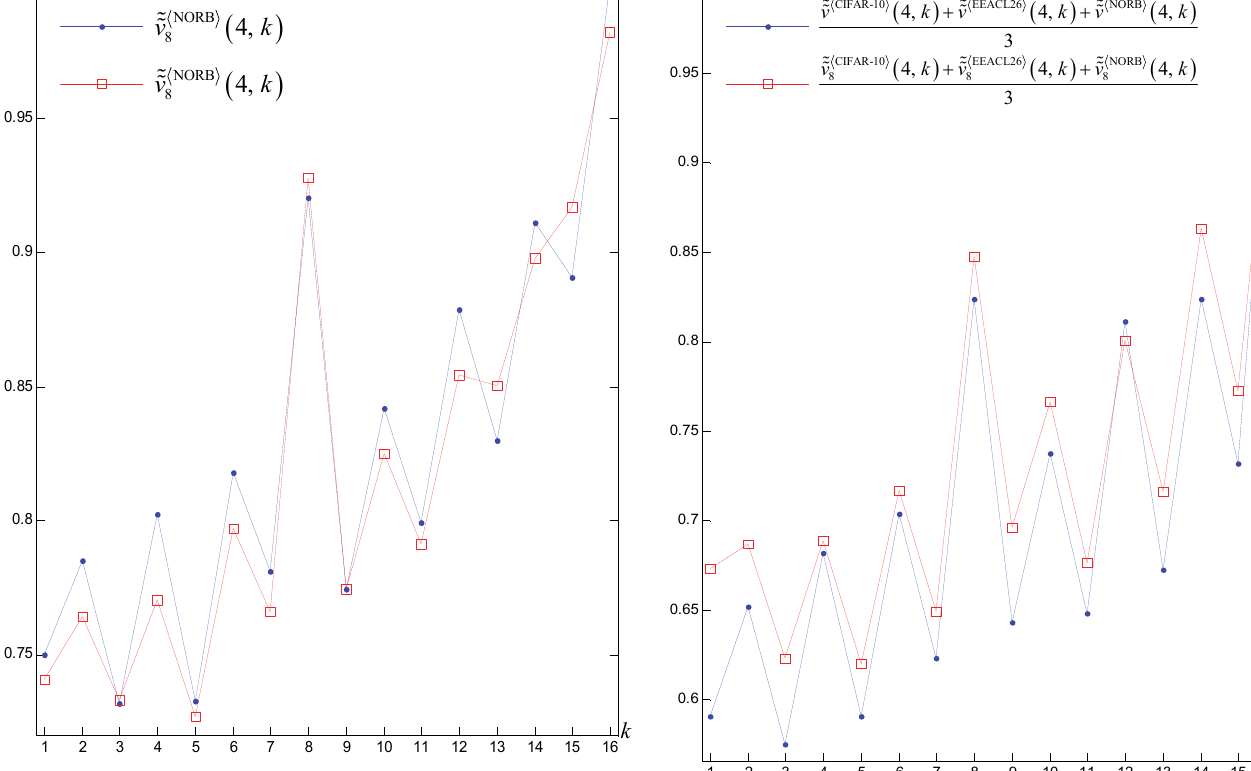
4 N  . Minima do not coincide. ConvL